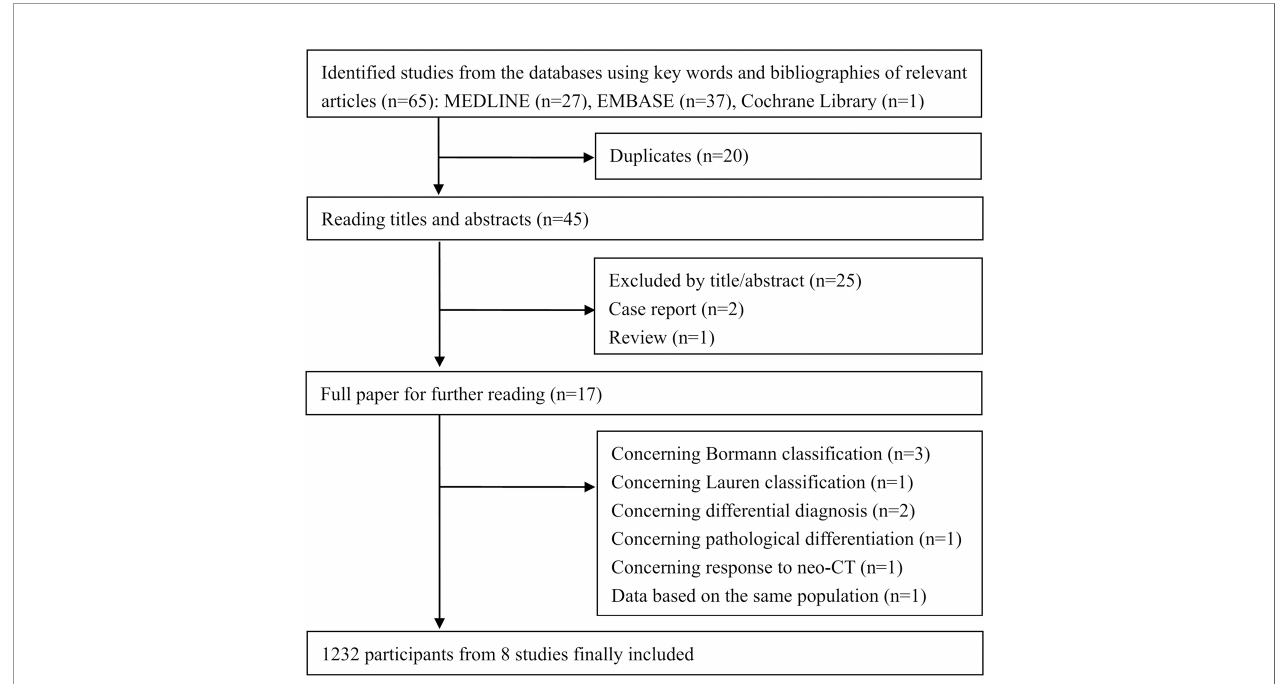
FIGURE 1 | Flow of studies through the review process. neo-CT, neoadjuvant chemotherapy.